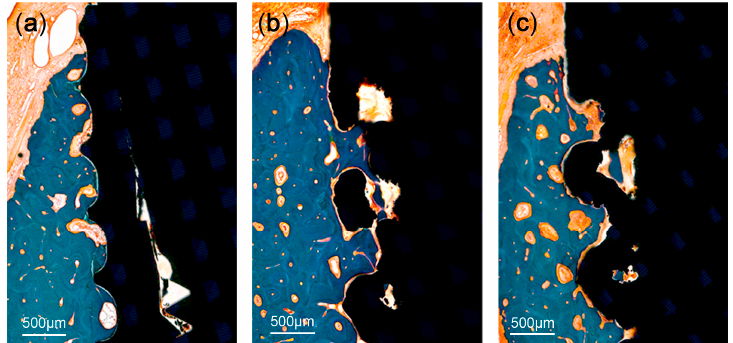
Figure 6. Histologic photograph of threaded implant: ( a ) 3D-printed implant without spikes, ( b ) 3D-printed implant with spikes, and ( c ) at 12 weeks following implant placement. The region within threads and within lattices was occupied with new bone. Primary bone remodeling had nearly ceased, while secondary remodeling was ongoing around all types of implants.